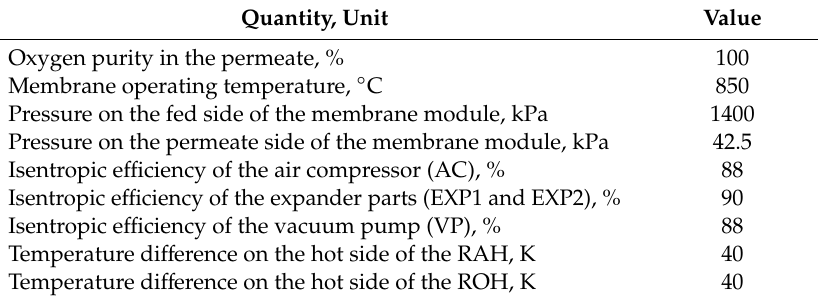
Table 5. Assumptions for the ASU equipped with a three-end type HTM (variant V3a). Quantity, Unit Value Oxygen purity in the permeate, % 100 Membrane operating temperature, ◦ C 850 Pressure on the fed side of the membrane module, kPa 1400 Pressure on the permeate side of the membrane module, kPa 42.5 Isentropic e ffi ciency of the air compressor (AC), % 88 Isentropic e ffi ciency of the expander parts (EXP1 and EXP2), % 90 Isentropic e ffi ciency of the vacuum pump (VP), % 88 Temperature di ff erence on the hot side of the RAH, K 40 Temperature di ff erence on the hot side of the ROH, K 40